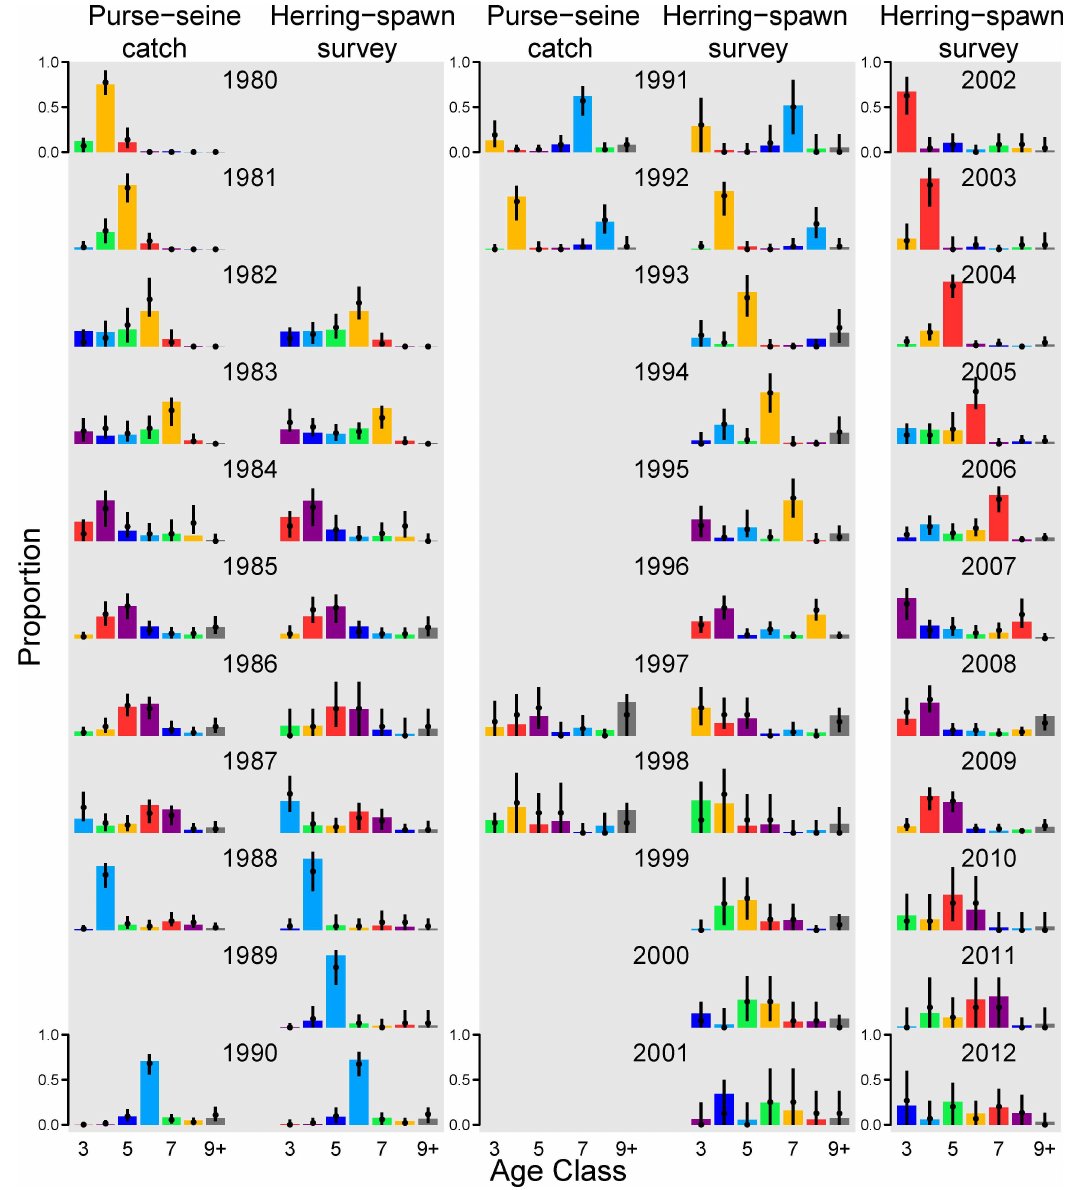
Fig 6. Model fits to the two sets of age-composition data used: proportion of catch-at-age from the purse-seine fishery and age-composition proportions from the ADF&G herring-spawn survey. Coloredbars denotedata, colors track individualcohorts through time, and points show posterior median with bars showingthe 95% posterior intervals. No compositions are shown for years when the springfishery was closed (1989, 1993–1996, and after